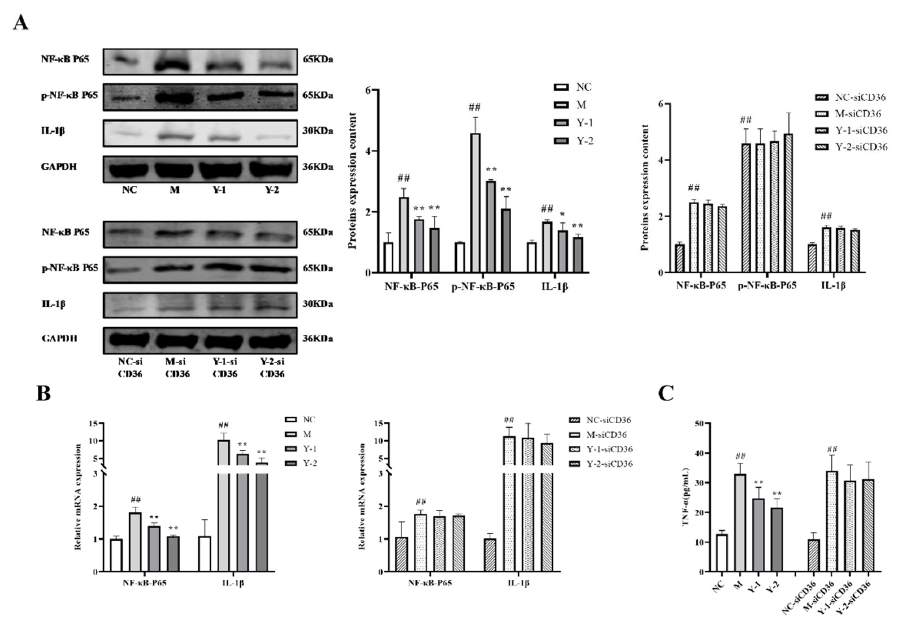
Figure 4. Effects of Y ‐ 1 and Y ‐ 2 on NRK ‐ 52e cells’ inflammatory cytokines stimulated by sodium oleate with/without CD36 silences representative. The expression of NF ‐κ B ‐ P65, p ‐ NF ‐κ B ‐ P65, and IL ‐ 1 β protein in NRK ‐ 52e cells were quantified by Western blot and normalized ( n = 3) ( A ). The expression of NF ‐κ B ‐ P65 and IL ‐ 1 β mRNA in NRK ‐ 52e cells were quantified by qRT ‐ PCR and normalized ( n = 3) ( B ). The levels of TNF ‐α in NRK ‐ 52e cells were determined by ELISA method ( n = 6) ( C ). Compared with NC or NC ‐ sicD36 group, ## p < 0.01; compared with M or M ‐ sicD36 group, * p < 0.05, ** p < 0.01.